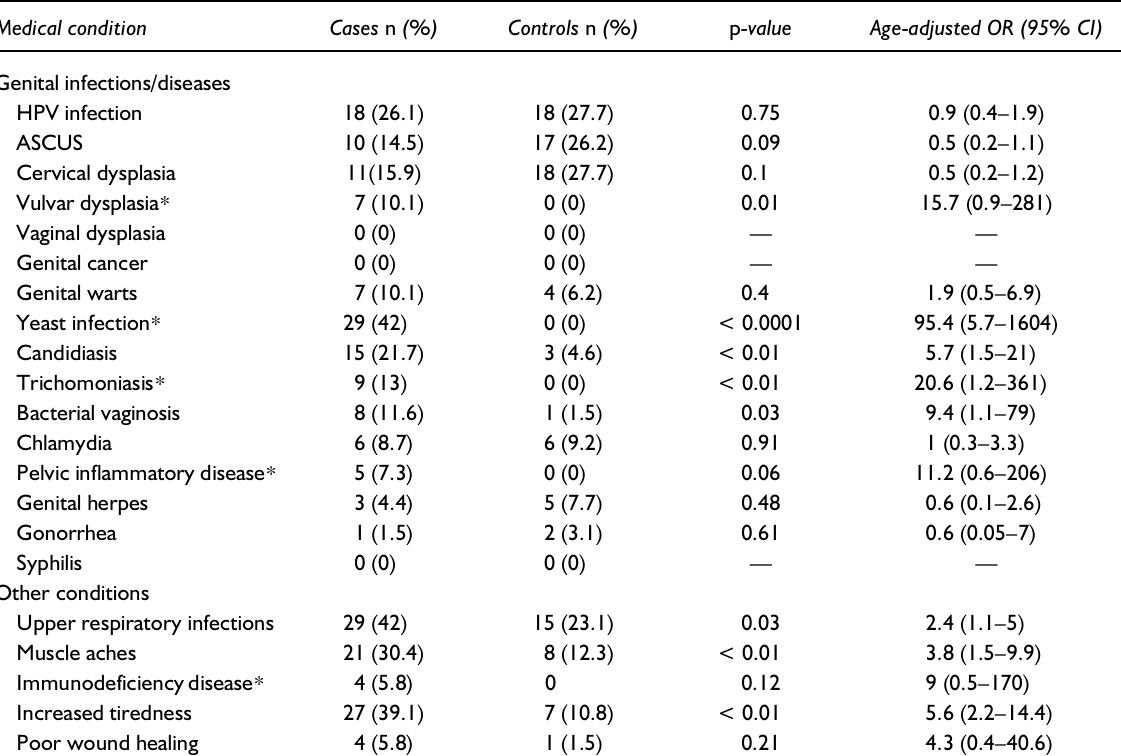
Table 3 Physician-diagnosed genital infections and other medical conditions of VVS cases and